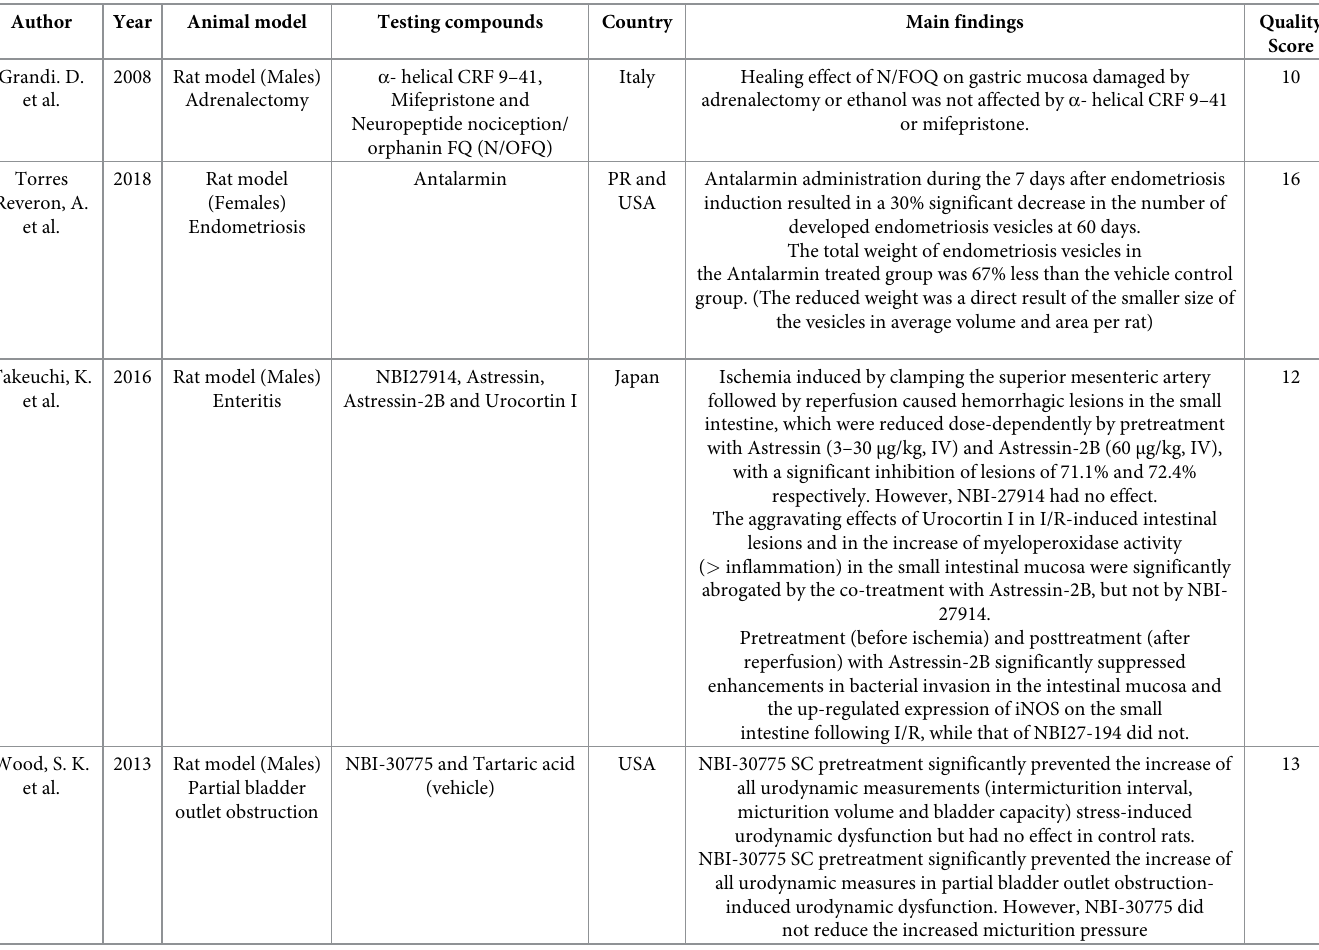
Table 4. Surgical models.